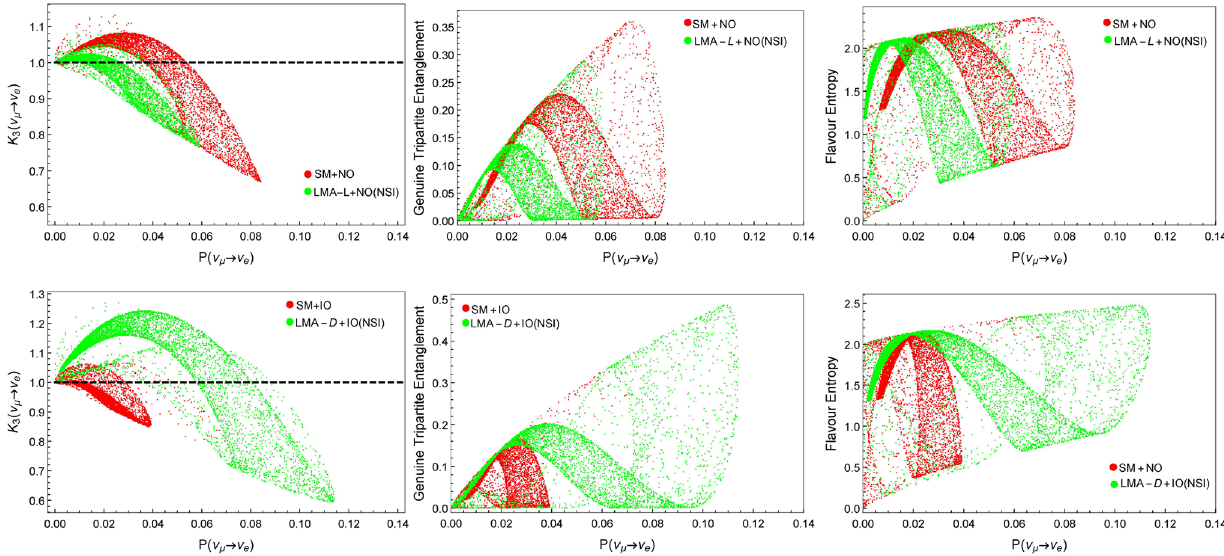
Fig. 4 This figure represents the correlation of nonclassicality measure K 3 (first column), genuine tripartite entanglement G (second column) and flavour entropy S (third column) with transition probability P (ν μ → ν e )